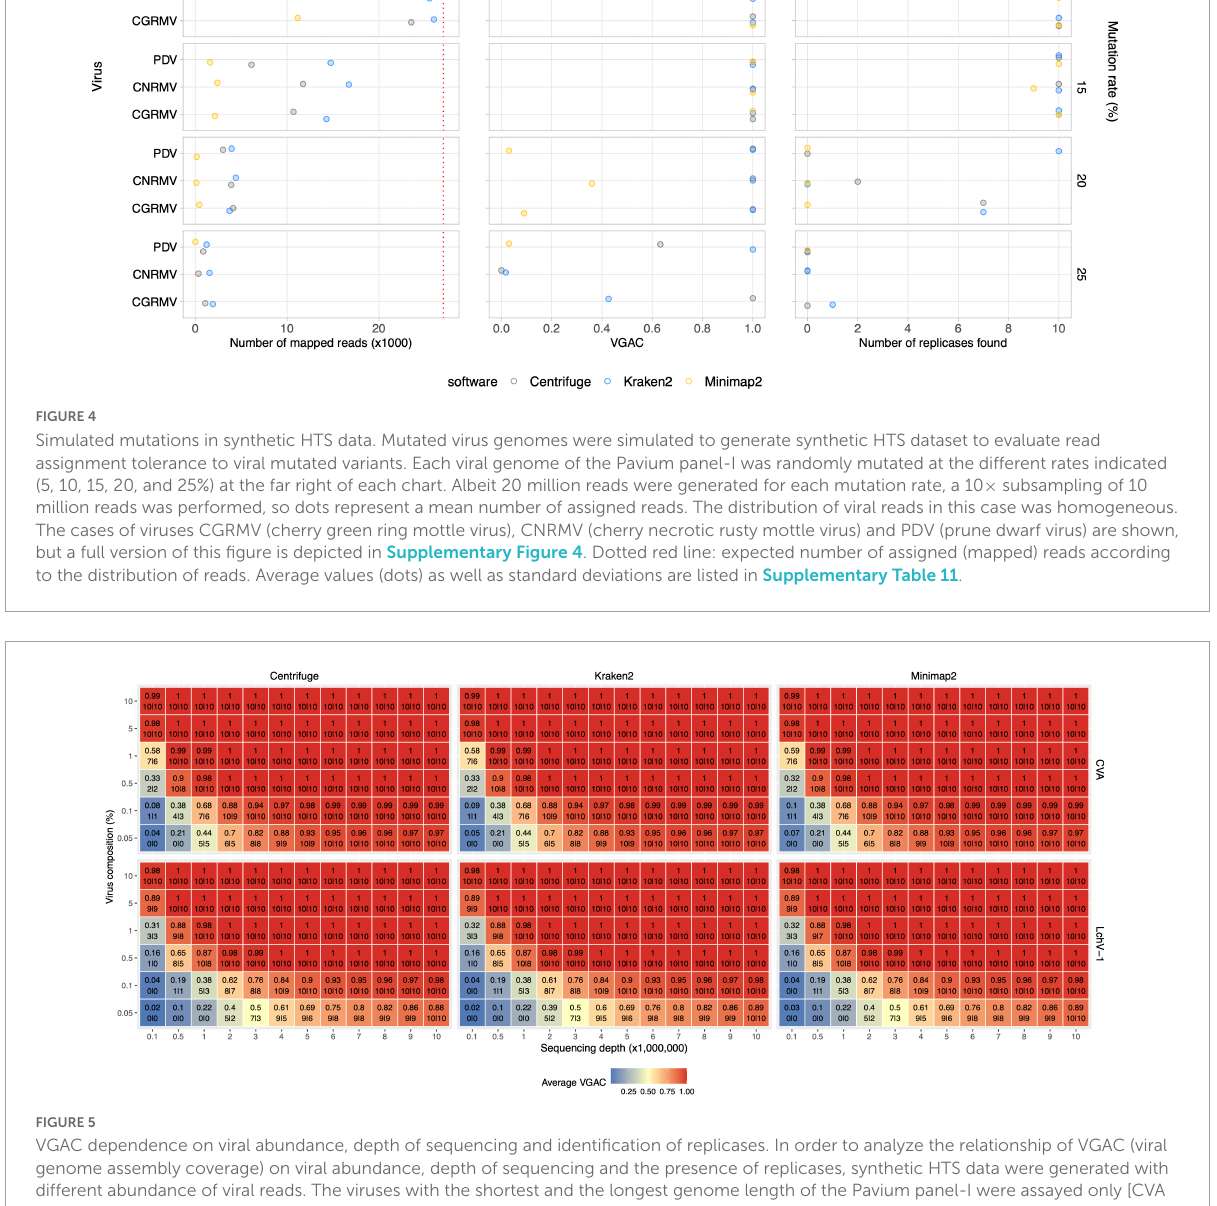
central region of the reference genome, and the replicase in this virus is at the 3 (cid:48) -region (hence no replicases detected). A similar issue was observed in the case of CYVMV, where no contig